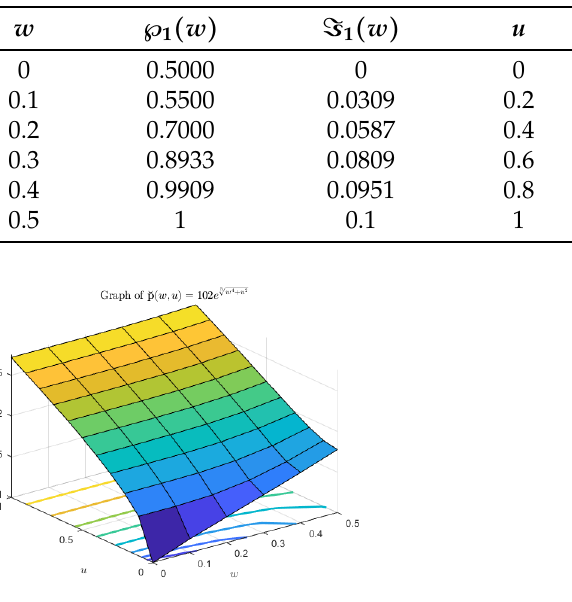
Figure 1. The graph of ˘p ( w , u ) in Example 1.